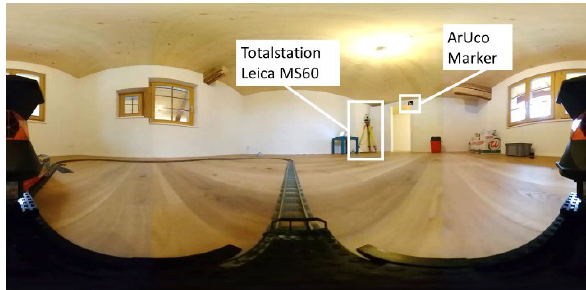
Figure 2. Equirectangular camera image depicting totalstation and marker (right) together with 360° prism (at the left and right image border)